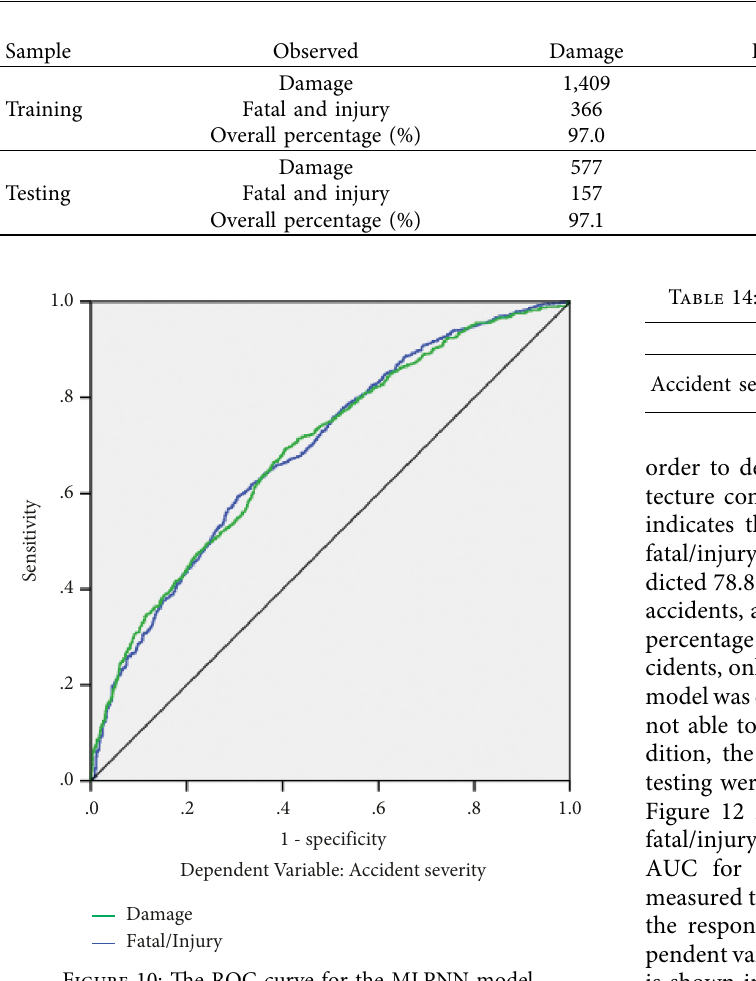
Figure 10: The ROC curve for the MLPNN model.